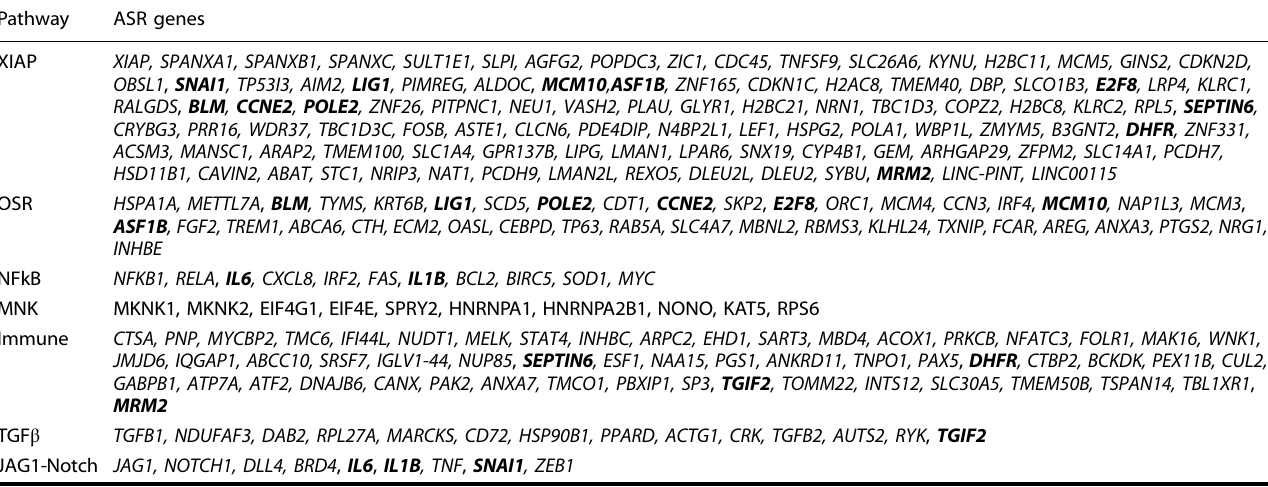
Table 1. The list of ASR genes and their functional pathways.